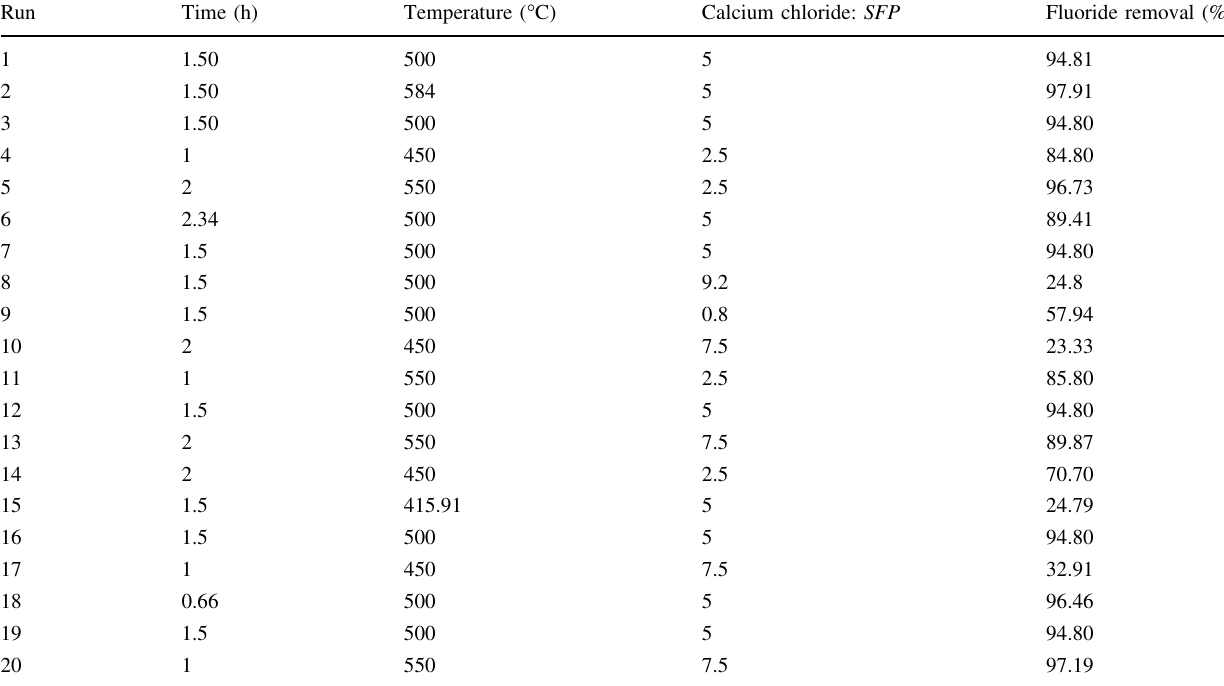
Table 1 Experimental design and response to prepare calcium-impregnated carbonized sal flower petal (CCSFP)